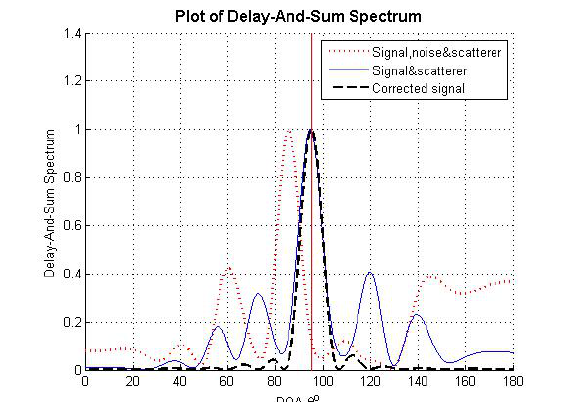
Figure 16: DOA spectrum for case 3